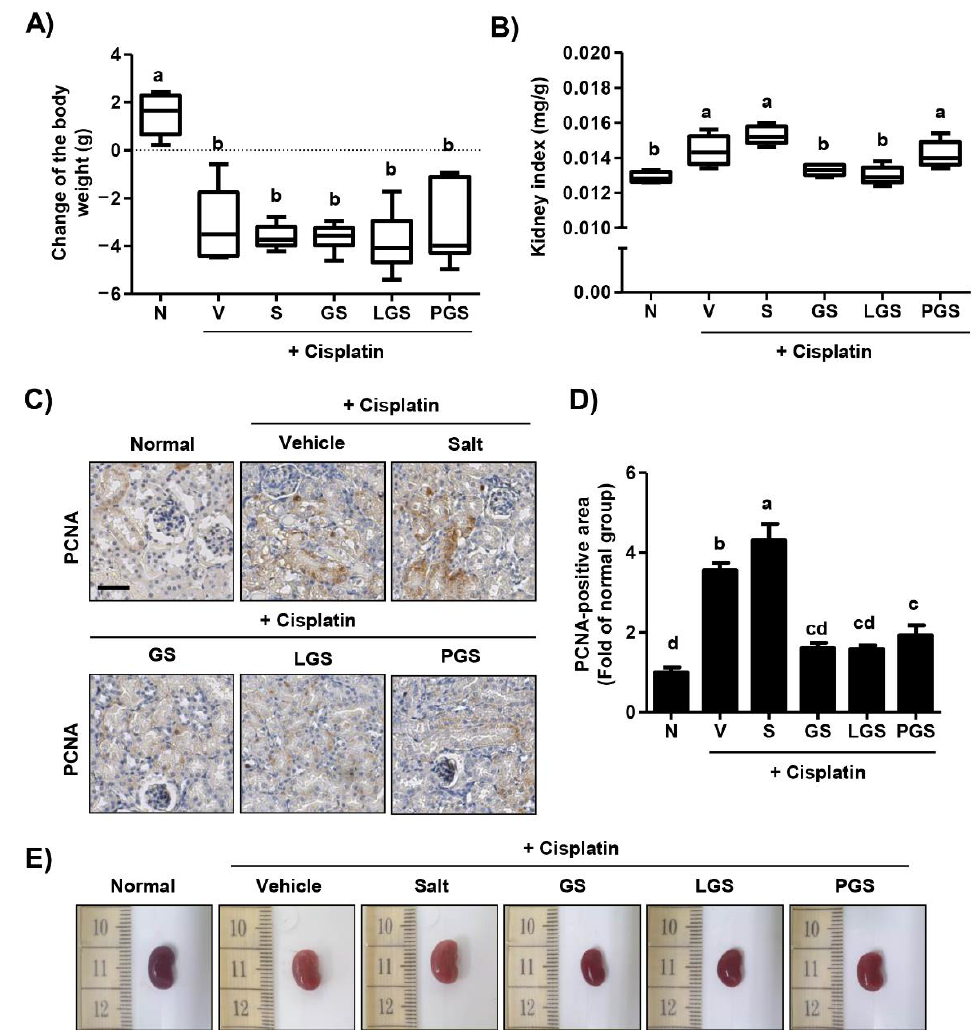
Figure 1. Effect of GABA on body weight loss and renal hypertrophy following high salt intake in cisplatin-induced acute nephrotoxicity. ( A ) Change of body weight. ( B ) Kidney/body weight ratio. Data are expressed as means ± SD ( n = 8 ). a – b Bars with different letters are significantly different at p < 0.05 by Tukey test. ( C ) Intra-renal expression of proliferating cell nuclear antigen (PCNA). Scale bar = 100 μm. ( D ) Quantitative analysis for the positive area of PCNA. Data are expressed as means ± SD ( n = 4). a – d Bars with different letters are significantly different at p < 0.05 by Tukey test. ( E ) Representative kidney images. N, normal group; V, cisplatin + saline group; S, cisplatin+ 4% high salt group; GS, cisplatin + high salt containing gamma aminobutyric acid (GABA) group; LGS, cis- platin + 4% sodium containing lacto GABA salt group; PGS, cisplatin + 4% sodium containing post- biotics GABA salt group.